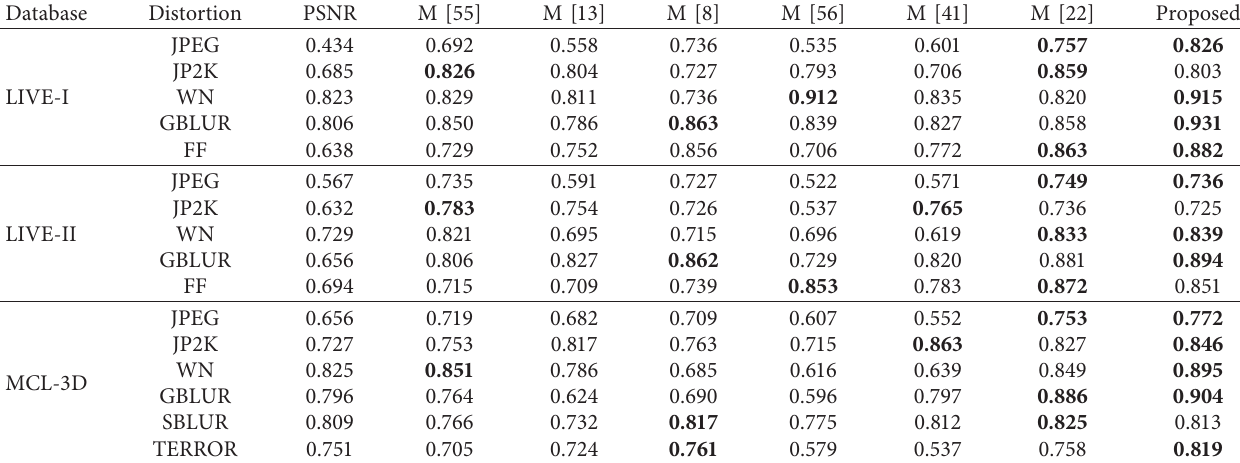
Table 4: KRCC comparison for each type of distortion.